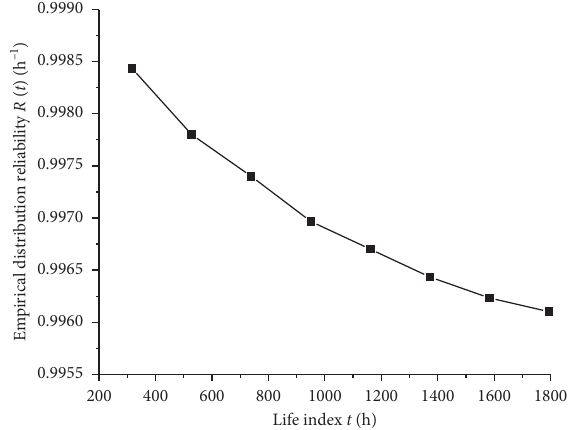
Figure 4: Reliability of empirical distribution.